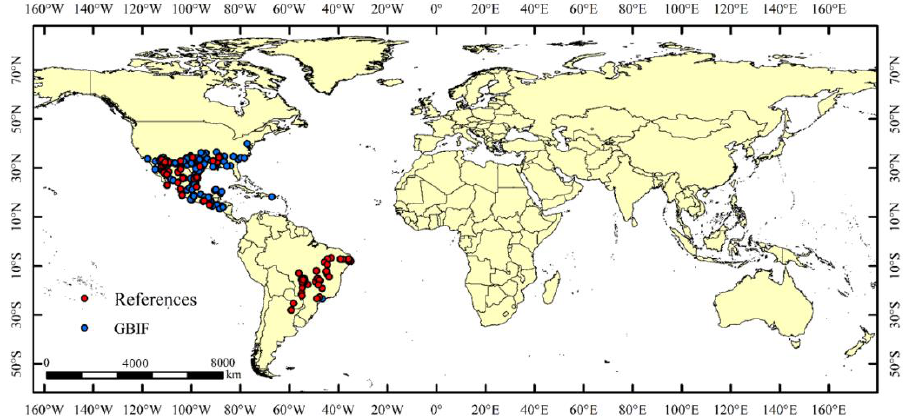
Figure 1. Global known sampling point distribution of Anthonomus grandis .